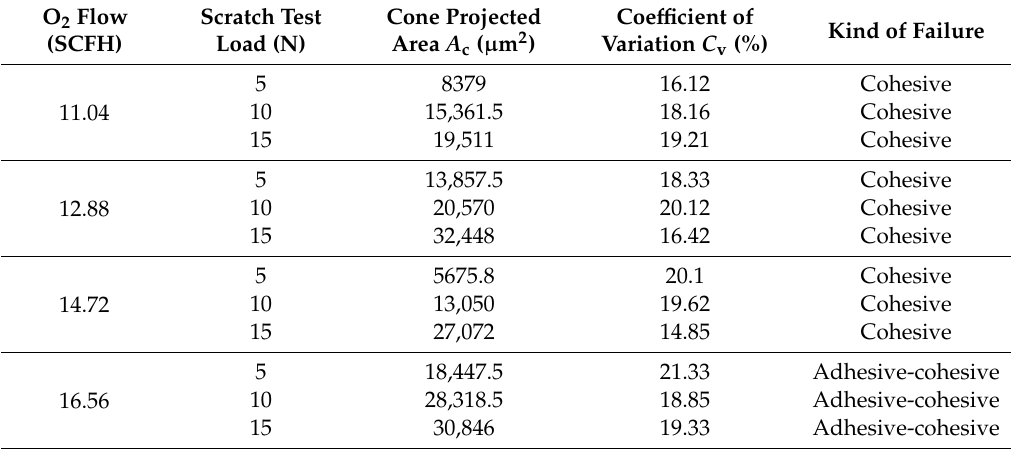
Table 3. Scratch test parameters of NiTec